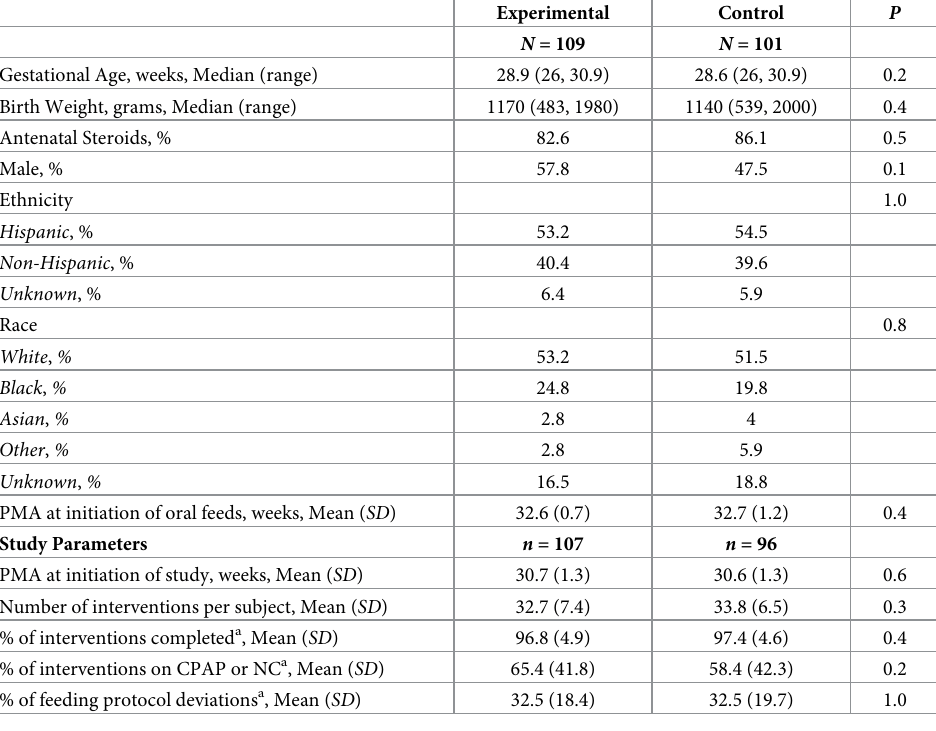
Experimental Control P N = 109 N = 101